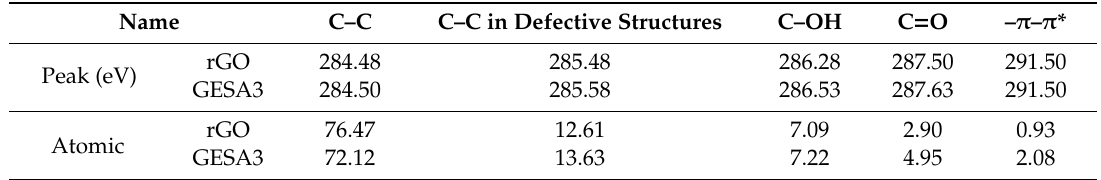
Table 1. Peak and area of rGO and GESA3.